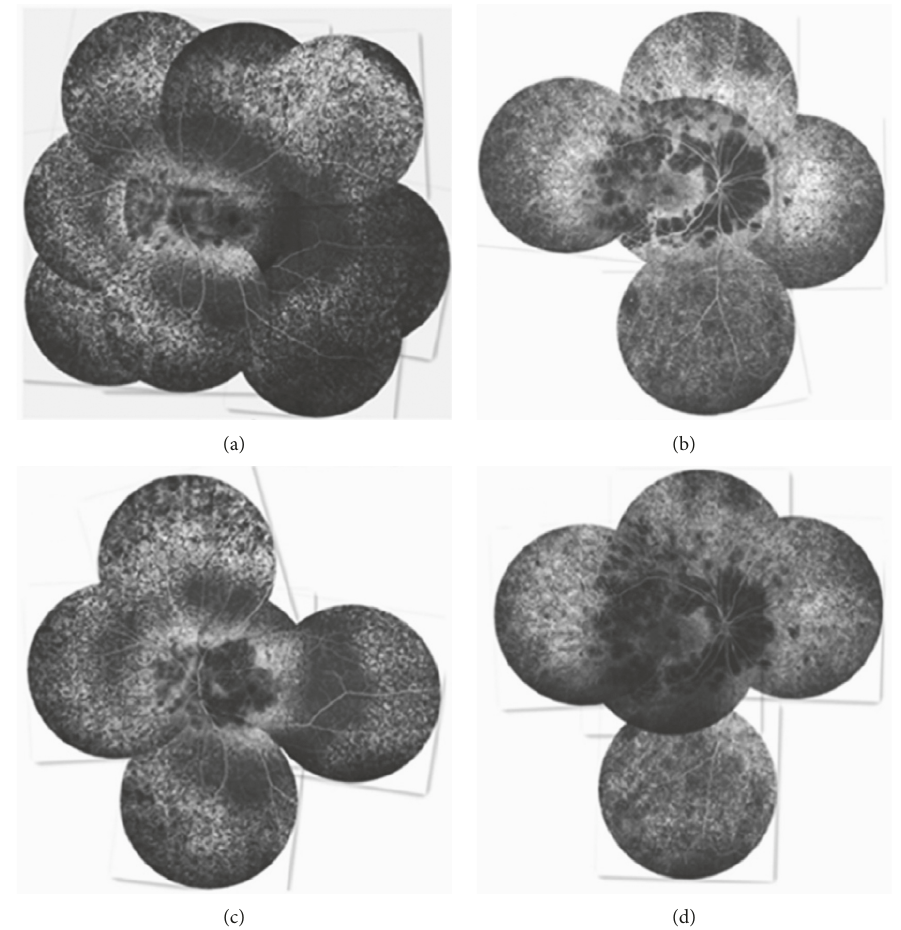
Figure 4: Comparison of first and last fundus angiography in patients with type 1 and type 2 BCD. (a) and (c): Puzzles of the first and last angiography images, respectively, of left eye of type 1 patient P1, showing that the hypofluorescence of the posterior pole expanded, and the peripheral and posterior pole lesions developed to the mid-peripheral. (b) and (c): Puzzles of the first and last fundus angiography images, respectively, of the right eye of type 2 patient P4, showing no significant changes in the macula area and the hypofluorescence around macula area enlarged.